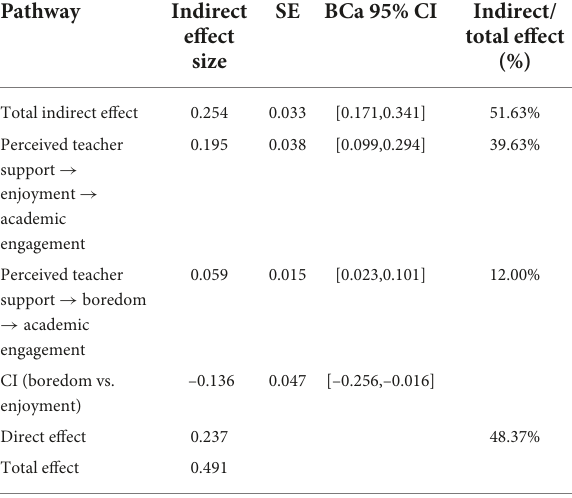
TABLE 5 Analysis of the parallel mediation